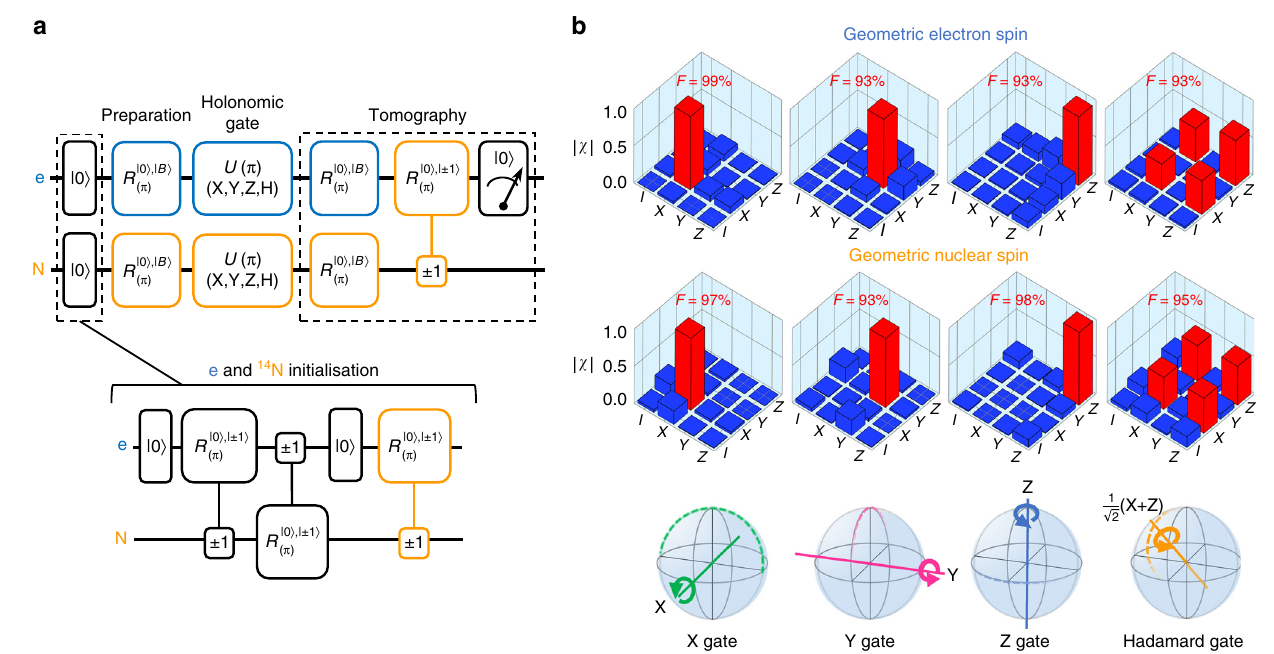
Fig. 2 Holonomic single-qubit gates. a The quantum circuit of holonomic gate process tomography for geometric electron and nuclear spin qubits. The blue (orange) quantum circuits indicate the operation for the geometric electron (nuclear) spin. The gate R 0 j i ; ± 1 j i ð π Þ indicates the π -rotation on the target spin in the 0 j i (cid:2) ± 1 j i space conditioned by the control spin state |±1 〉 (double-sign corresponds) (Methods). b The χ matrices (absolute values) to show the fi delity of the holonomic single-qubit quantum gates for the X, Y, Z, and Hadamard (H) gates over the geometric electron and nitrogen nuclear spins reconstructed by quantum process tomography. The X, Y, Z, and H gates indicate π -rotation around the X, Y, Z, and 1 ffiffi correspond to the direction de fi ned by | + 〉 and | − 〉 , | + i 〉 and | − i 〉 , and | + 1 〉 and | − 1 〉 , as shown in Fig. 1c. The F indicates fi delity and the bars indicate the values of the matrix